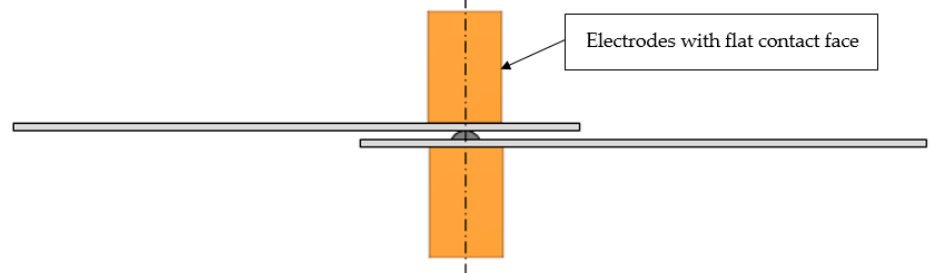
Figure 3. Schematic drawing of spot welding using additive manufacturing.